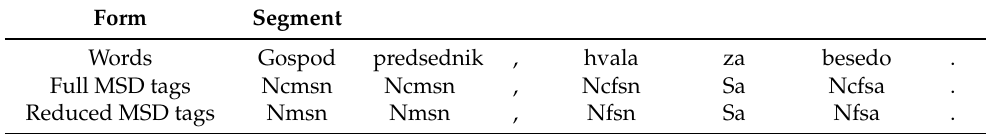
Table 7. An example segment tagged with full and reduced MSD